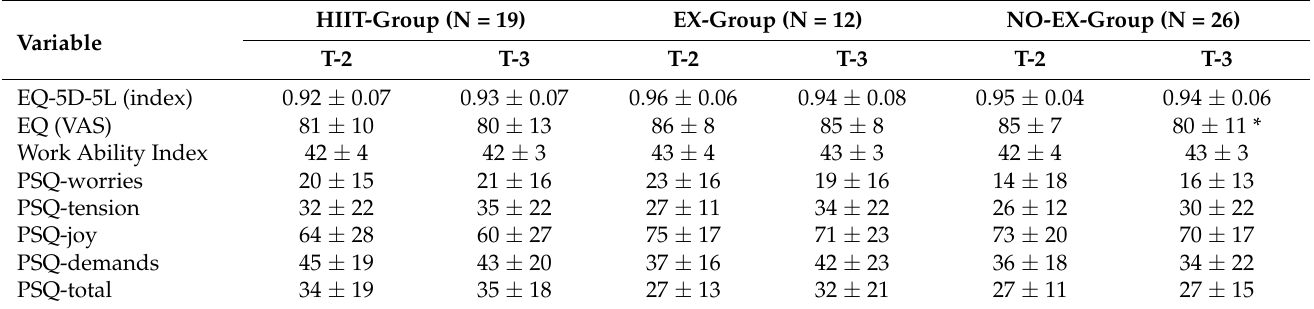
Table 7. Mean values and standard deviations (SD) of participants’ (N = 57) self-reported outcomes at post-intervention (T-2) and follow-up